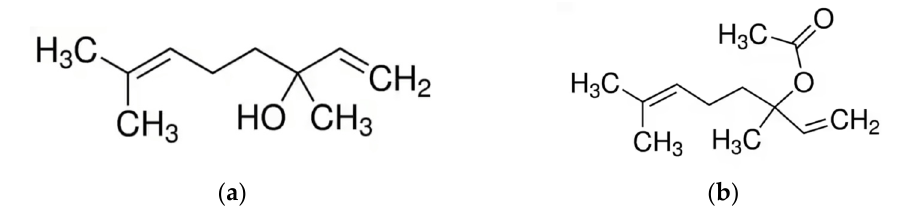
Figure 5. Main components of Lavandula Eos. ( a ) Linalool; ( b ) Linalyl acetate. Lavandula angustifolia showed e ffi ciency against pathogenic isolates from milk ( Staph- ylococcus spp., Bacillus cereus , and Kytococcus sedentarius ) [85]. Lavandula stoechas reduced signi fi cantly the bacterial population of Staphylococcus au- reus , Streptococcus agalactiae , and Escherichia coli , with MIC values of 4.37, 3.75, and 3.12% v/v , respectively